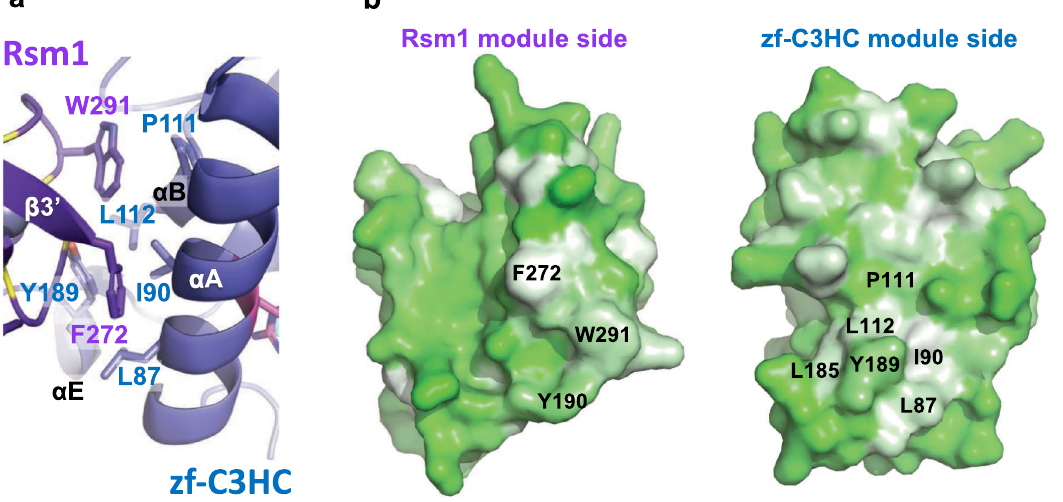
Figure 3. Hydrophobic interface between zf-C3HC and Rsm1 modules. ( a ) Residues involved in van der Waals’ contacts are shown in stick representation. ( b ) Hydrophobicity of Rsm1 and zf-C3HC module are shown using PyMOL script color_h, ranging from white (highly hydrophobic) to green (less